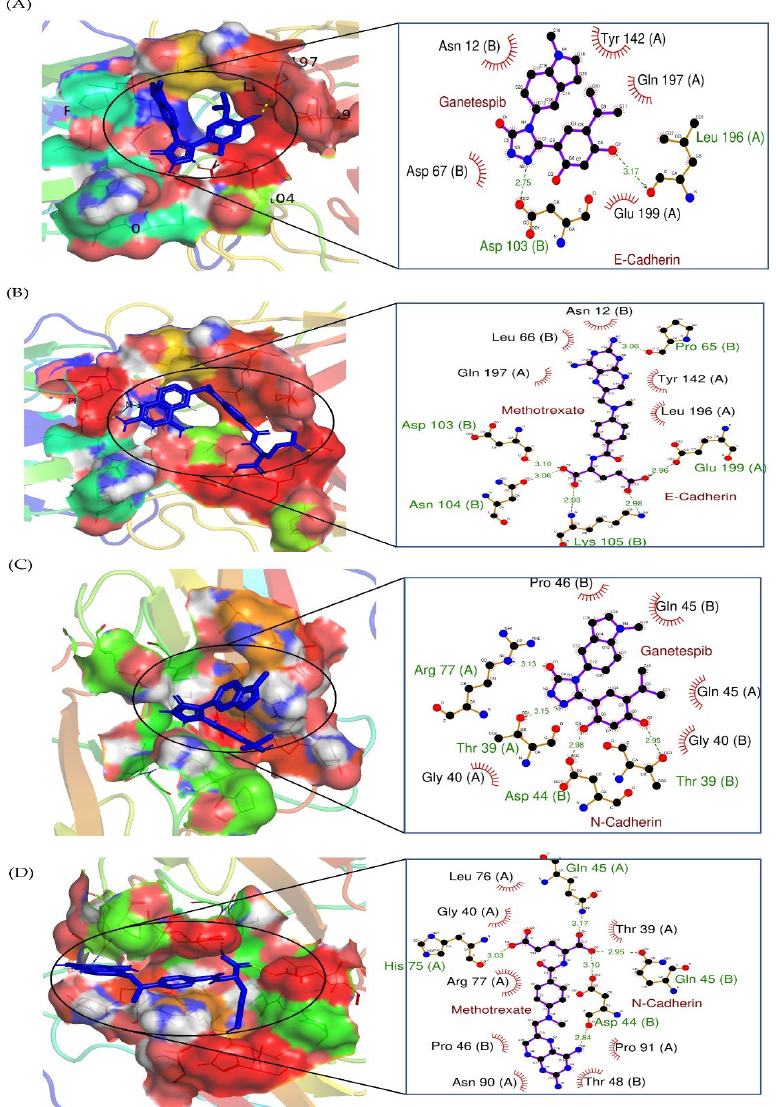
Figure 7. Two-dimensional interaction complex of ( A ) GAN and ( C ) MTX with E-cadherin protein, where red shows the target protein, purple shows the ligand molecule, and the black circle shows the enlarged view of docked complex. Two-dimensional interaction complex of ( B ) GAN and ( D ) MTX with N-cadherin protein, where red shows the target protein, purple shows the ligand molecule, and the black circle shows the enlarged view of the docked complex.